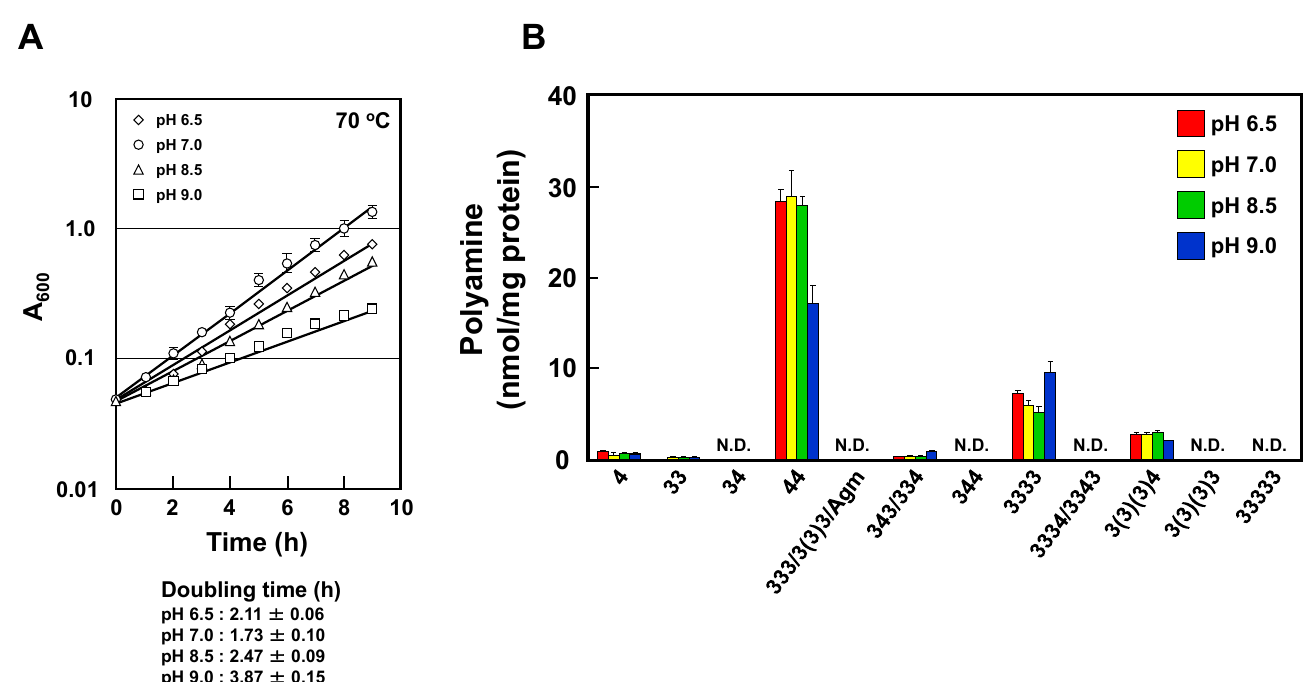
Figure 4. Cell growth and polyamine content of T. thermophilus HB8 Δ speE strain grown at various pHs. ( A ) Cell growth of T. thermophilus HB8 Δ speE strain grown at pH 6.5 ( ◇ ), 7.0 ( ○ ), 8.5 ( △ ) or 9.0 ( □ ). The temperature was fixed at 70 °C. The results are shown as means ± standard errors. ( B ) Polyamine content in cells harvested at an A 600 of 0.5 was measured as described in Materials and Methods. HPLC chromatograms are shown in Figure S2B. The contents are shown as means ± stand- ard errors, n = 3. N.D., Not detected.